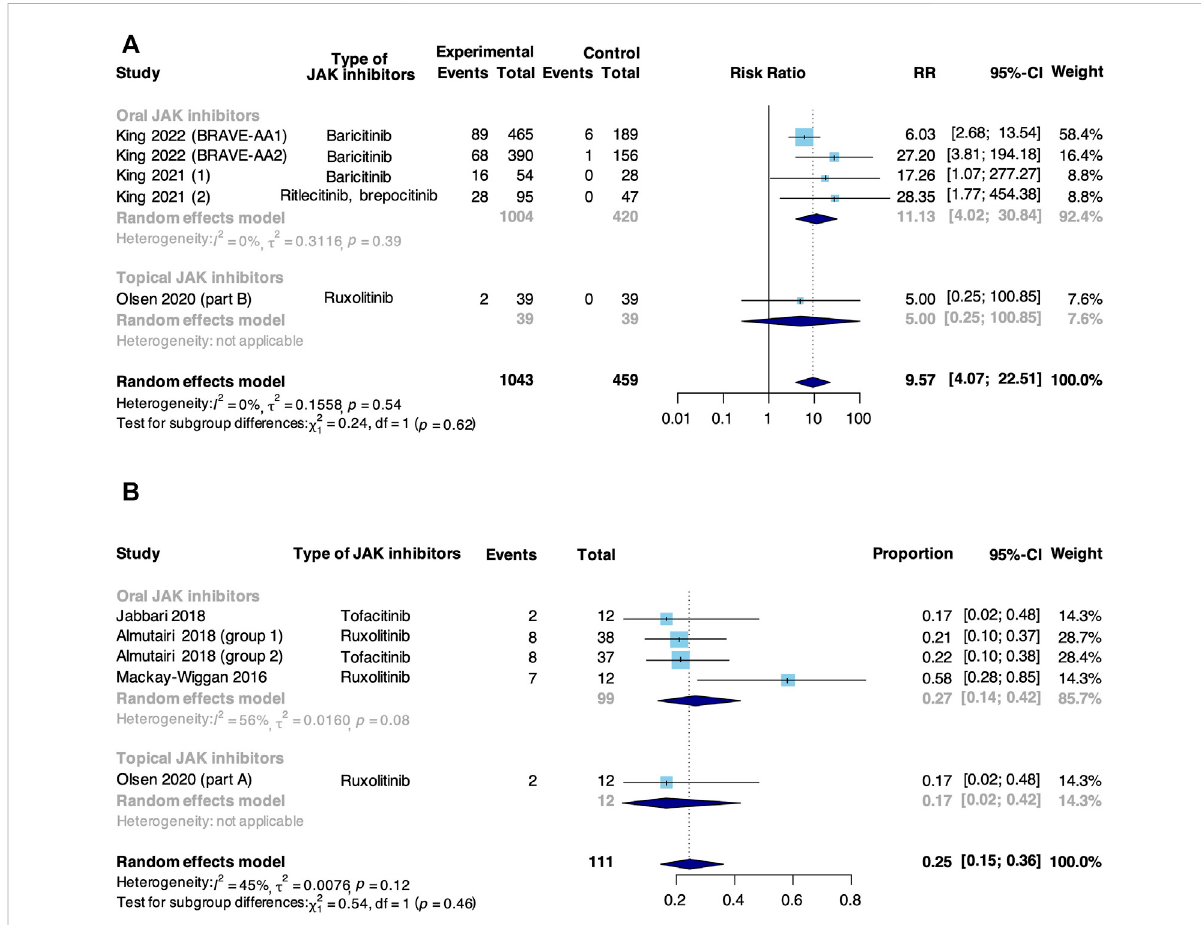
FIGURE 3 Forest plot of the pooled rate of complete response to JAK inhibitors in patients with AA based on (A) RCTs and (B)